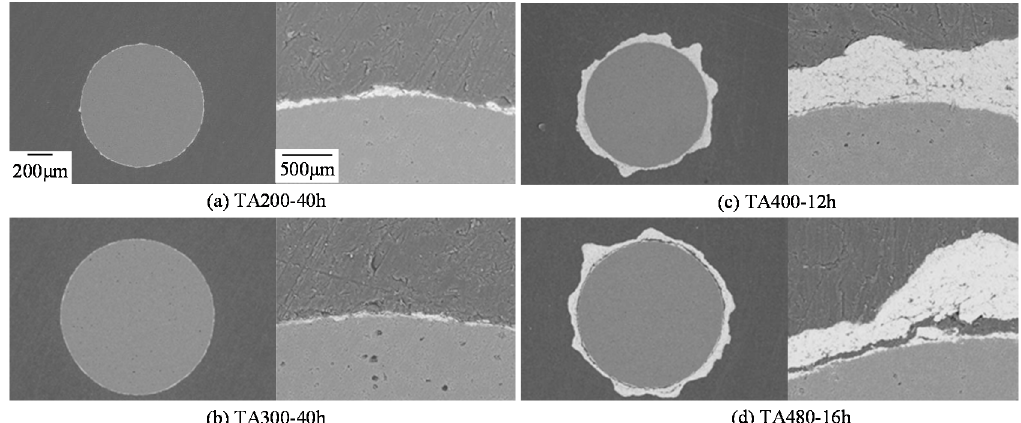
Figure 18. SEM images of cross-sectional structure of the